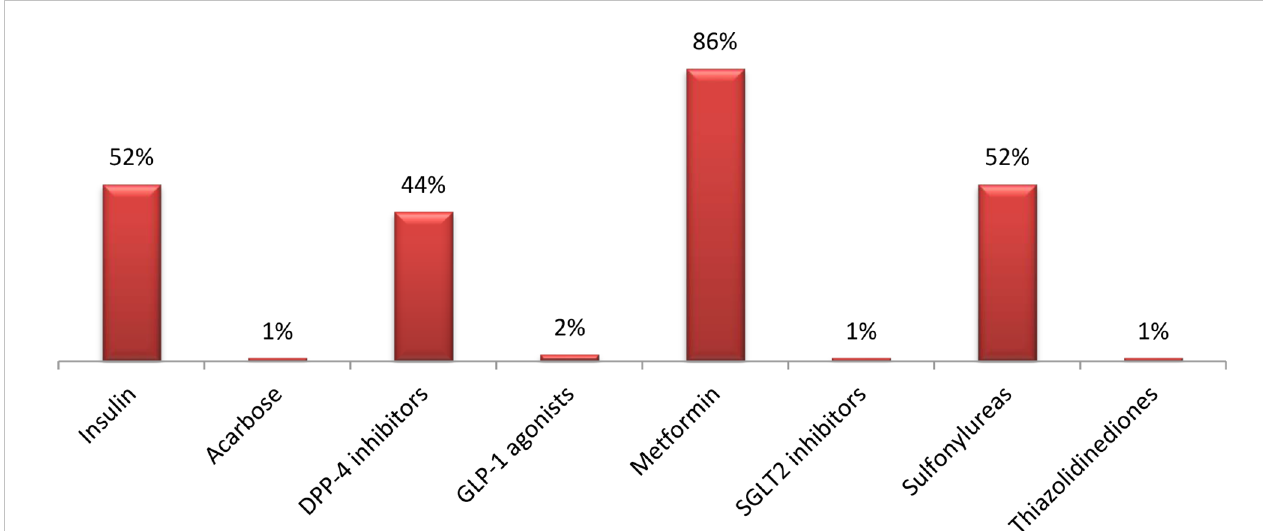
FIGURE 3 Percentage (%) of patients on different classes of anti-diabetic medications. Insulin: Regular, Aspart, NPH, Human insulin 70/30, Degludec, Detemir, Glargine. Alpha-glucosidase inhibitor: Acarbose. Dipeptidyl peptidase 4 (DDP-4) inhibitors: Linagliptin, Sitagliptin. Glucagon-like peptide-1 receptor (GLP-1) agonists: Liraglutide, Semaglutide. Biguanide: Metformin. Sodium-glucose cotransporter-2 (SGLT2) inhibitors: Dapagli fl ozin, Empagli fl ozin. Sulfonylureas: Glibenclamide, Gliclazide, Glimepiride, Glipizide. Thiazolidinedione: